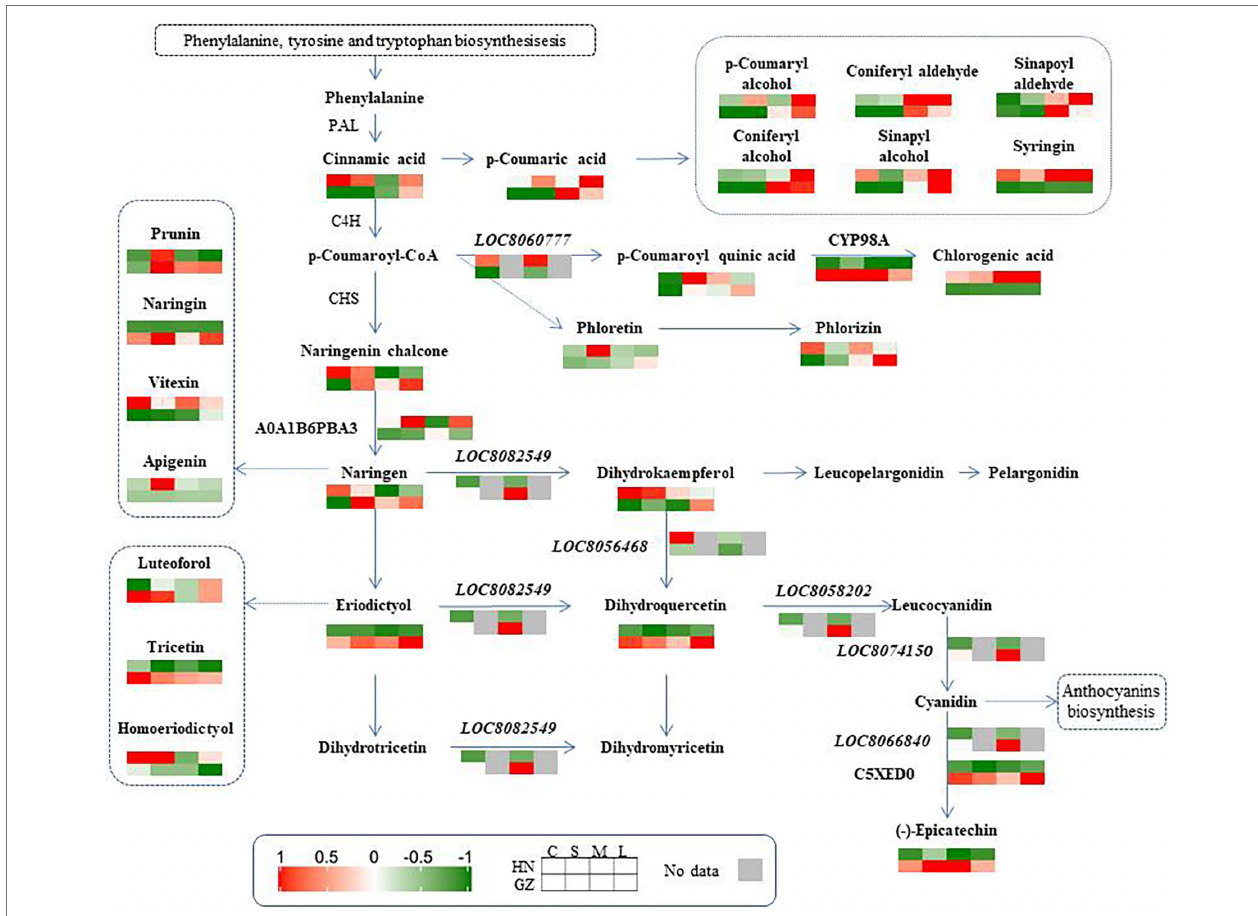
FIGURE 7 | Phenylpropanoid and Flavonoid biosynthesis pathway. Genes, proteins, and metabolites with differential abundance involved in phenylpropanoid and flavonoid biosynthesis metabolism were mapped to the corresponding metabolic pathways in